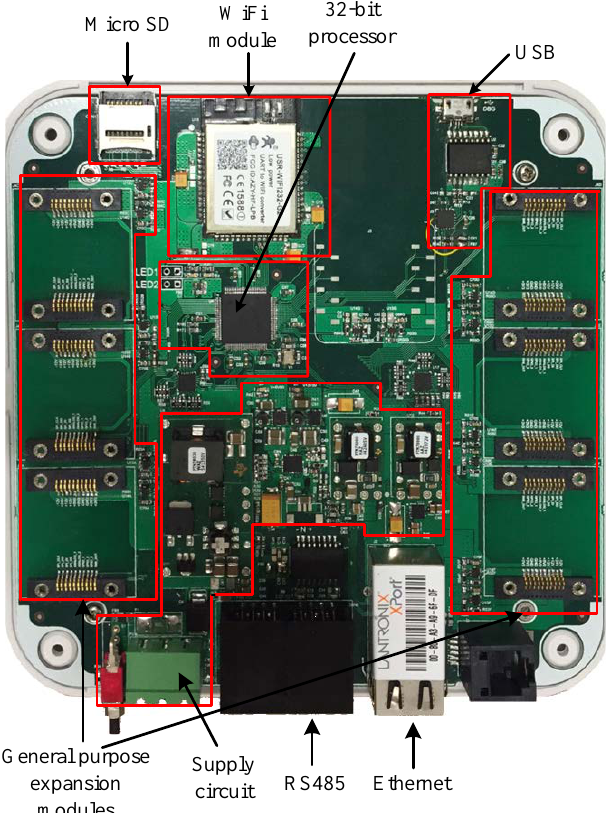
Figure 6. Image of the control central.